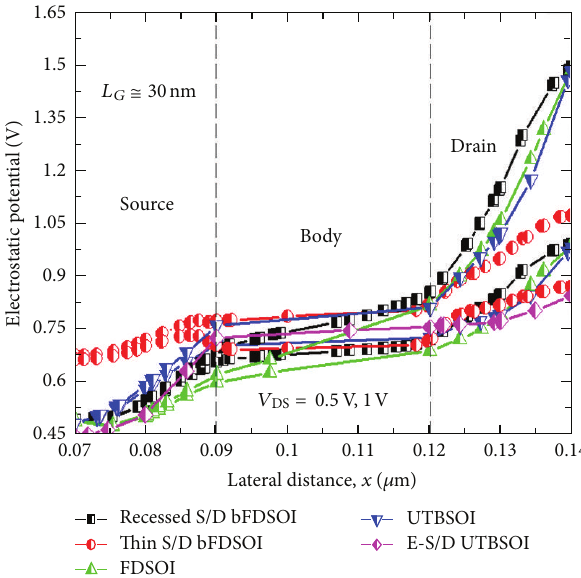
Figure 2: Simulated electrostatic potential (V) as a function of lateraldistancealongtheFETsinterfacewithgatelength 𝐿 𝐺 =30nm.